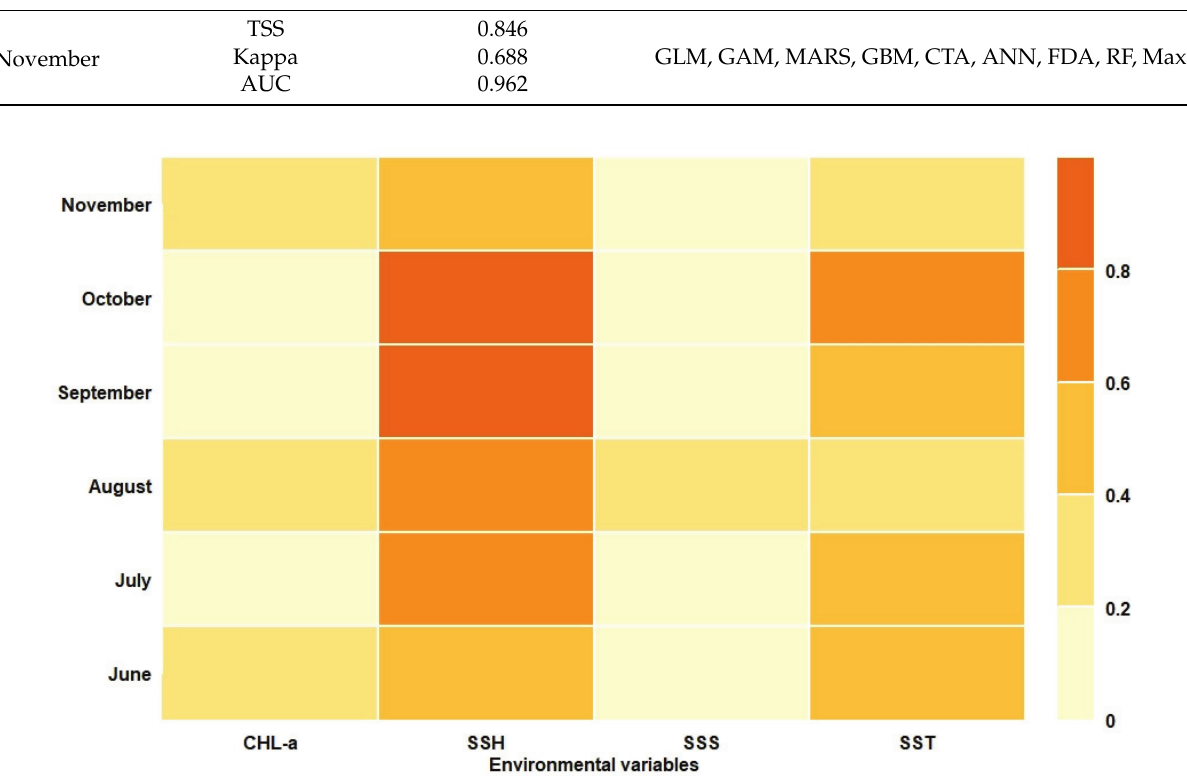
Figure 4. Permutation importance of the environmental variables for different months.